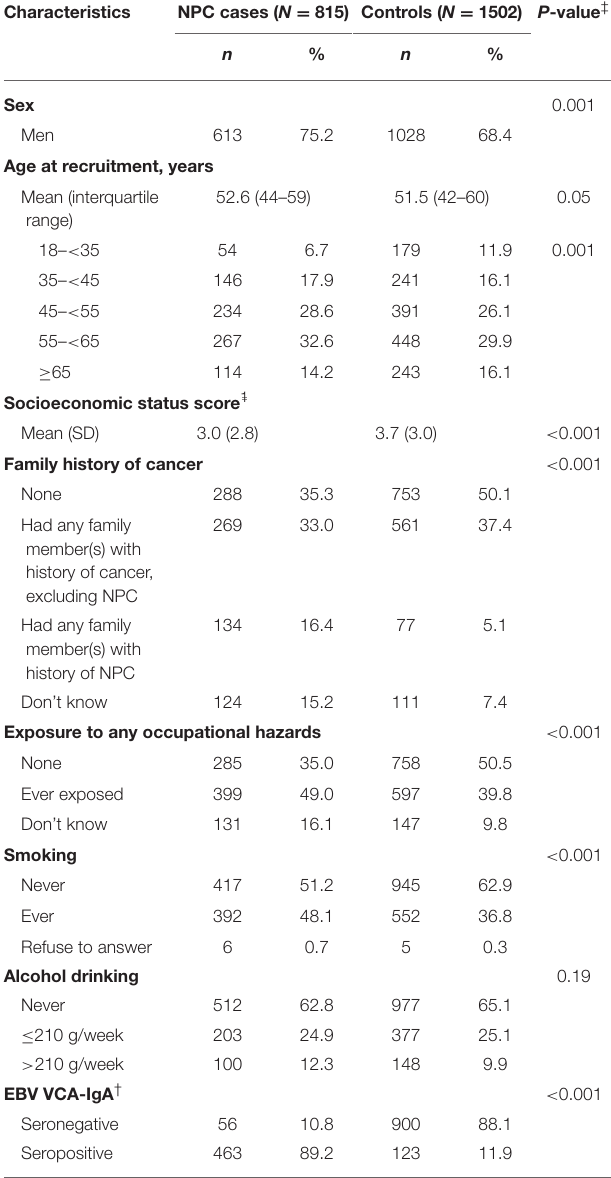
TABLE 1 | Characteristics of nasopharyngeal carcinoma (NPC) cases and controls in five regional hospitals in Hong Kong, China 2014–2017.